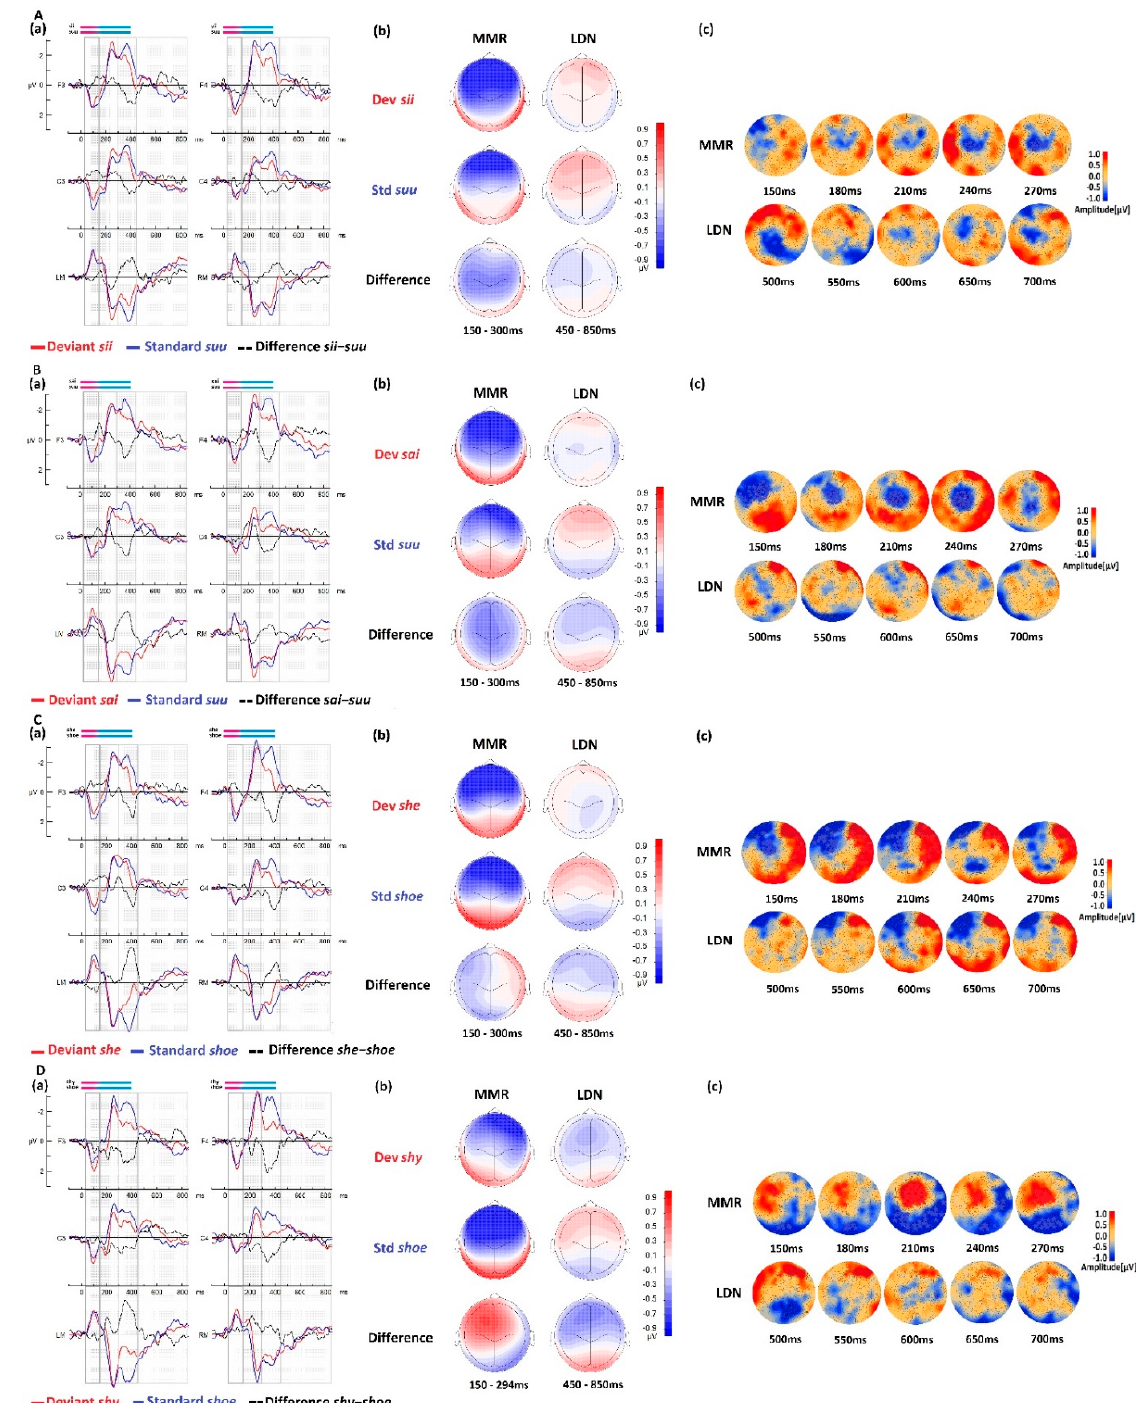
Figure 4. Average brain responses of the reading difficulties group ( N = 26) to the native conditions ( A ) sii - suu and ( B ) sai - suu and to the foreign conditions ( C ) she - shoe and ( D ) shy - shoe . ( a ) ERP waveforms of the native language deviant are shown in red, the standard in blue, and their difference wave deviant-standard in black. The windows of interest showing the MMR and the LDN components are highlighted in black boxes. ( b ) Corresponding means topographic maps over the MMR and LDN time windows. ( c ) The statistical cluster-based permutation test results showing signifi- cant differences between the responses to deviant and standard stimuli are indicated with stars. Blue and red colors indicate negative and positive amplitude values, respectively. The measuring unit is μ V.